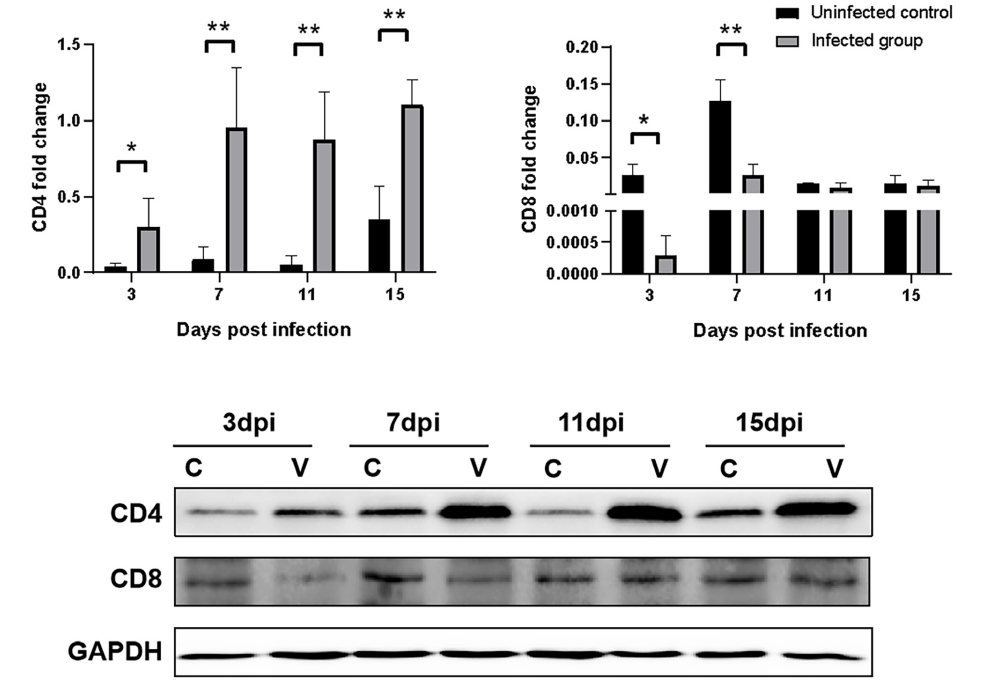
Figure 10. Changes in the protein levels of CD4 and CD8 in the spleen determined by Western blot at 3, 7, 11, and 15 dpi after infection with GNAstV. C: uninfected control group; V: GNAstV-infected group. Values are expressed as mean ± SD, n = 5. * p < 0.05; ** p <